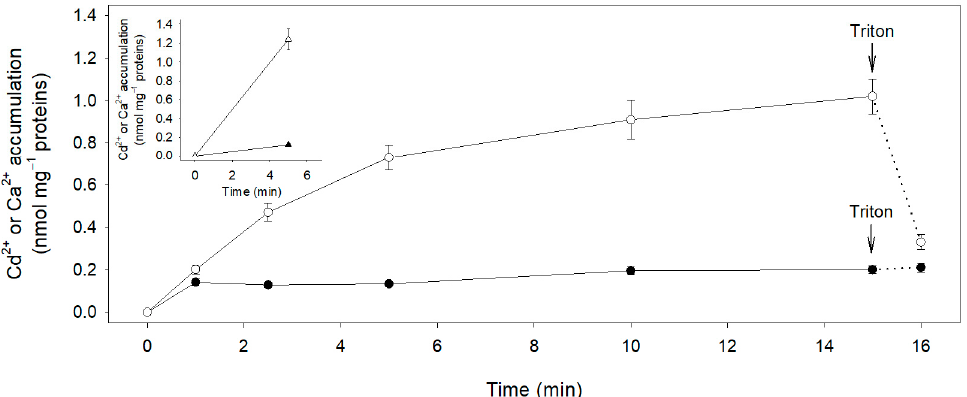
Figure 3. Time course of Cd 2+ and Ca 2+ accumulation in plasma membrane vesicles isolated from maize root cortical cells. Cd 2+ (filled circles) and Ca 2+ (open circles) accumulation in the vesicles were measured in the presence of protonophores. Arrows indicate the addition of Triton X-100 to the incubation media. The inset shows the proton dependent accumulation of Cd 2+ (filled triangles) and Ca 2+ (open triangles) in the vesicles measured in the absence of protonophores. Data are means ± SD of three independent experiments run in triplicate ( n = 3).